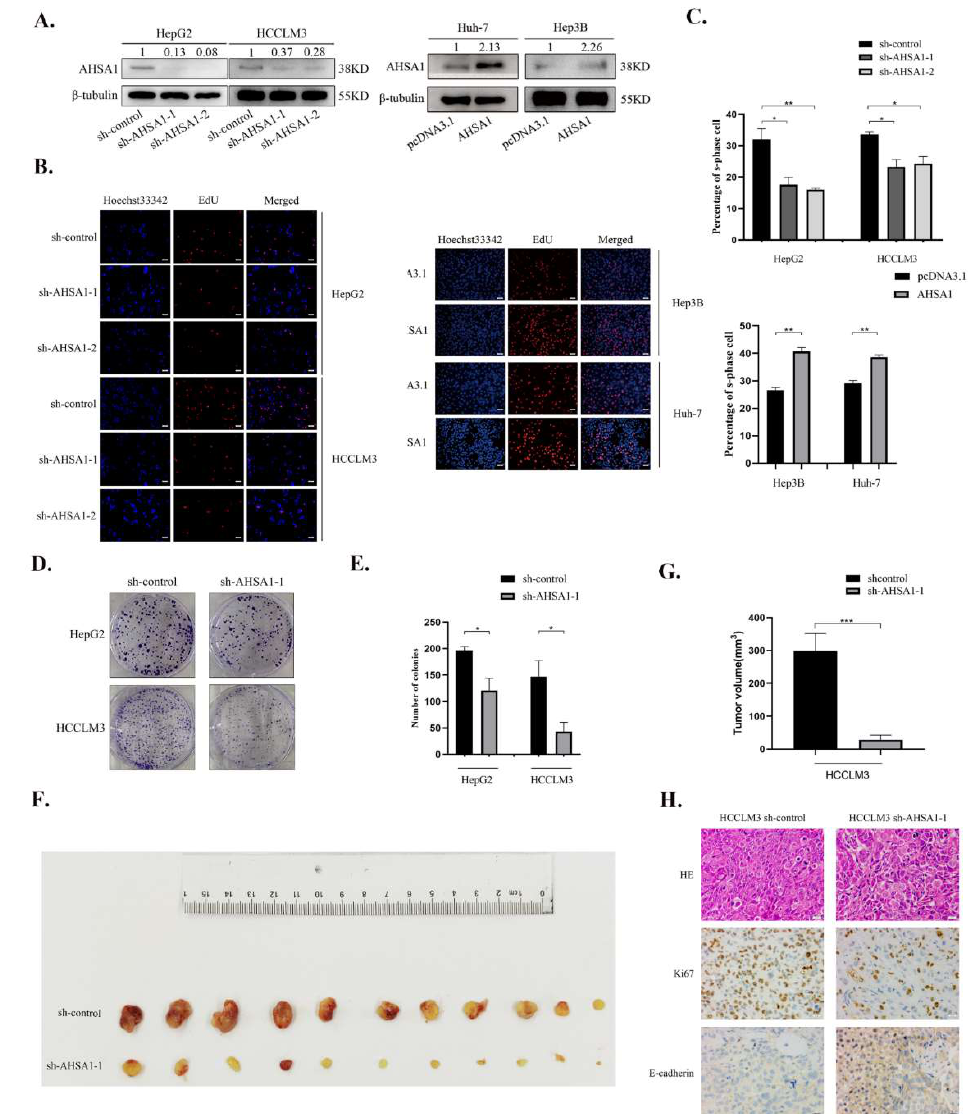
Figure 2. AHSA1 promoted the proliferation of HCC both in vitro and in vivo. ( A ). Transfection efficiency was determined by Western blotting in indicated HCC cell lines. ( B , C ). EdU detection and corresponding statistical analysis were performed on HCC cells. ( D , E ). Cell cloning and statistical analysis were performed on HCC cells after knocking down AHSA1. ( F , G ). Subcutaneous tumor and statistical analysis of tumor volume of HCCLM3-con and HCCLM3-shAHSA1 cells in nude mice. ( H ). HE and IHC staining of Ki-67 and E-cadherin in subcutaneous tumor tissue. *, p < 0.05; **, p < 0.01; ***, p < 0.001. The uncropped blots are shown in Supplementary Materials.